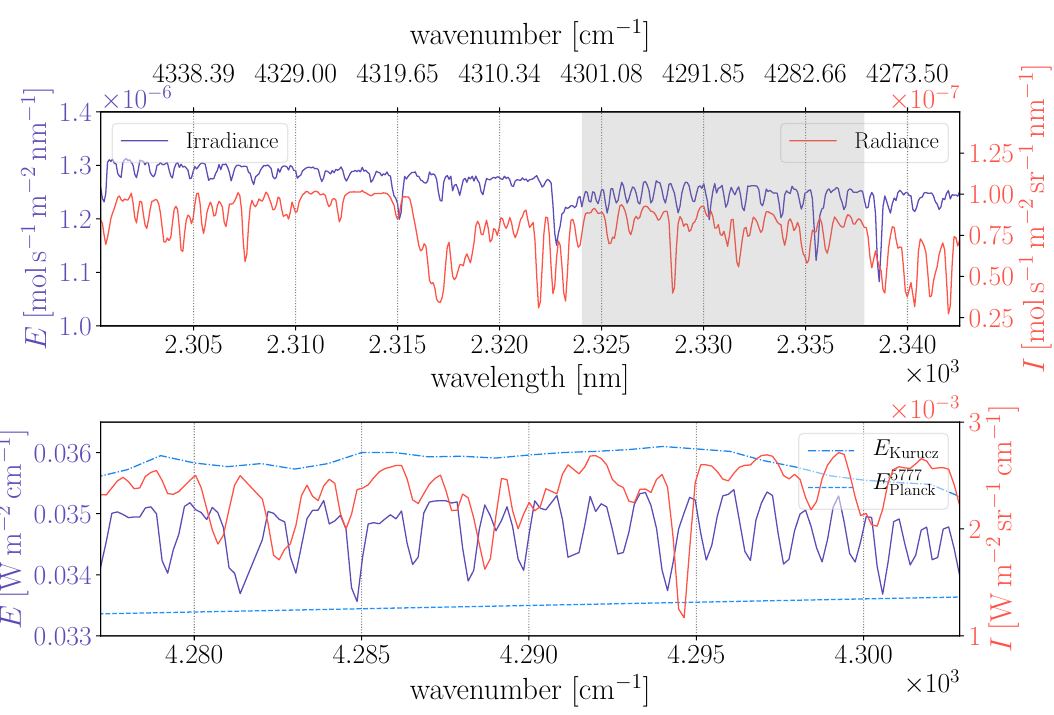
Figure 3. A calibrated level 1b photon radiance and irradiance spectrum from TROPOMI’s band 7 with SI (Système international d’unités) units mol s − 1 m − 2 nm − 1 and the retrieval window indicated in gray (top). The Earth radiance I was obtained in orbit 9093 at around 60 ◦ northern latitude, while the solar irradiance E was measured in orbit 9088. The lower panel depicts the retrieval window from 4277.20–4302.90 cm − 1 with units converted to Wm − 2 nm − 1 . E Kurucz and E 5777 describe the incident Planck solar irradiance at TOA (top of atmosphere) according to Kurucz [67] and an equivalent black body radiator at 5777K, respectively. Both were added for illustrative purpose